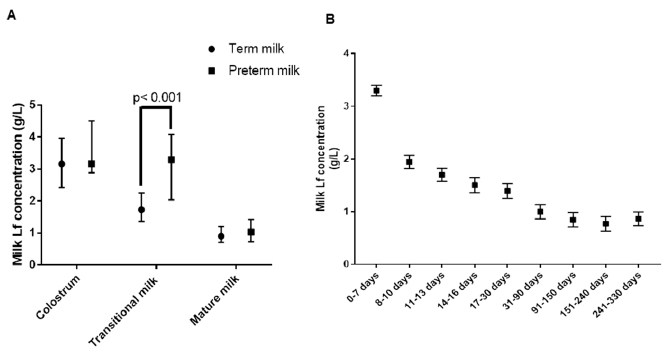
Figure 1. Milk Lf concentrations change among various lactation stages in Chinese